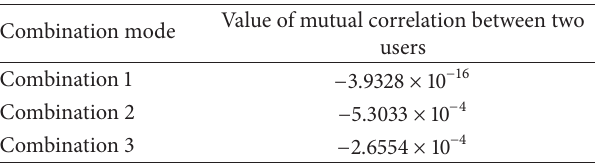
Table 6: Theoretical values of mutual correlation of 3 kinds of